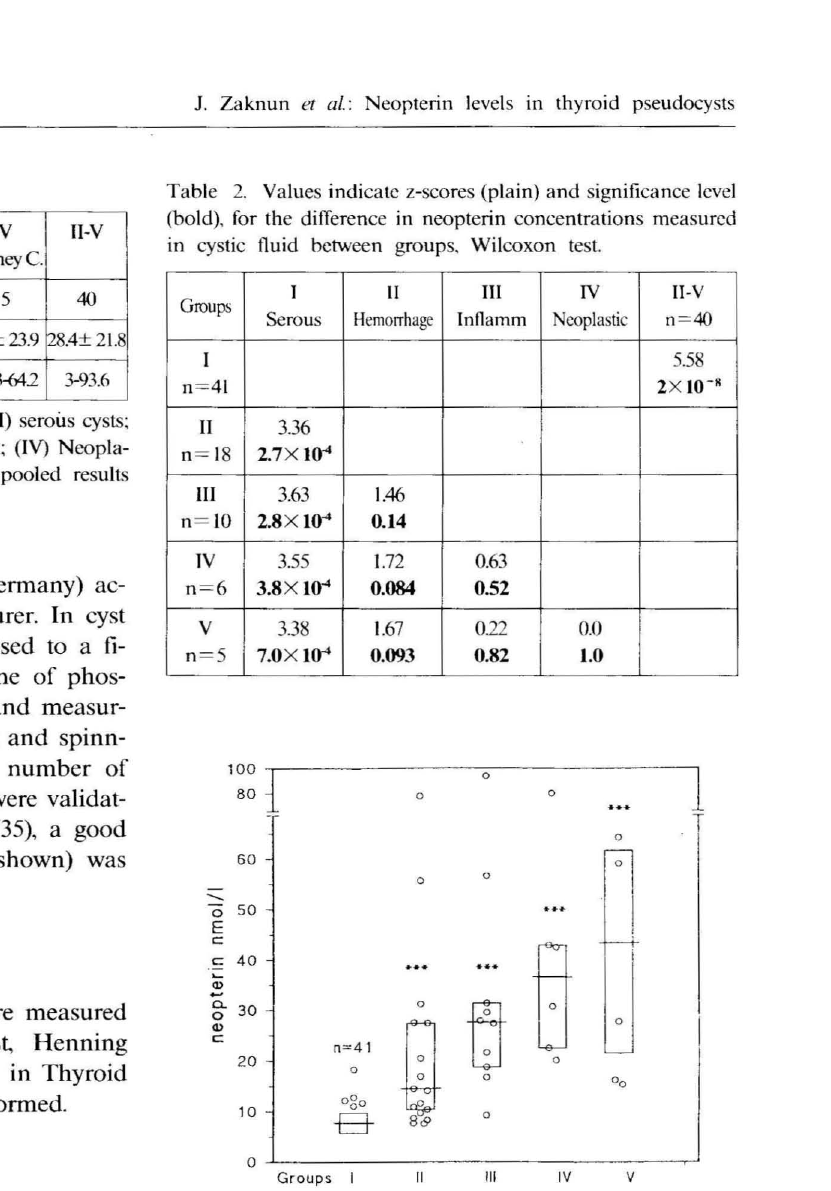
Table 1. II HI IV V II-V Groups Serous Hemorrhage InOamm Neoplastic HoneyC.